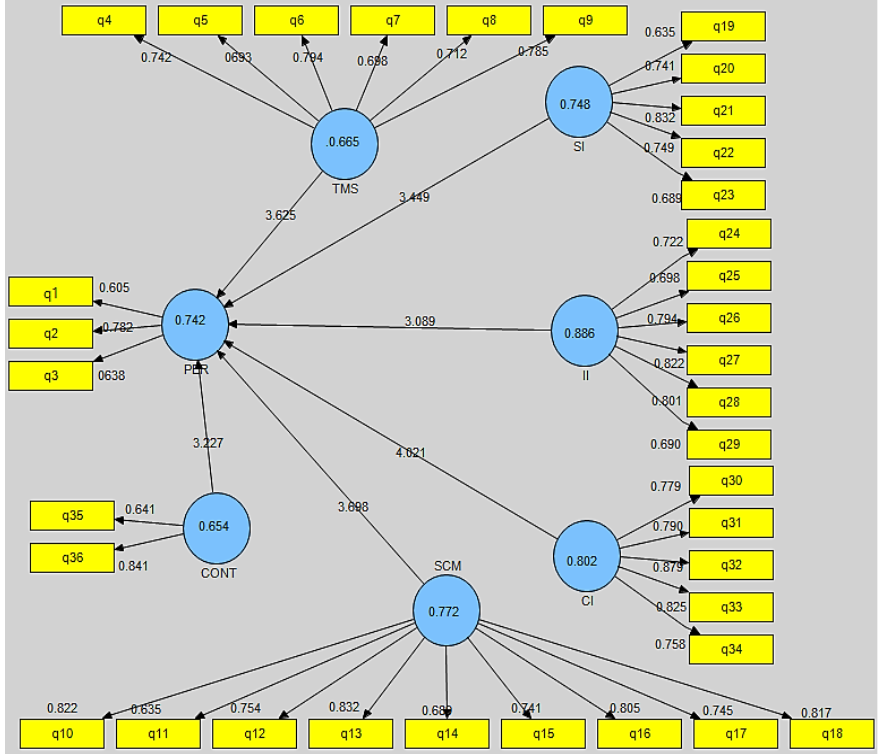
Fig. 1. The model goodness of fit (GOF) based on the standard